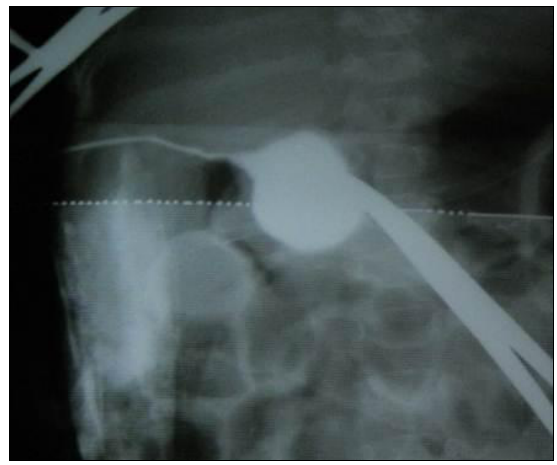
Figure 2: Peroperative cholangiogram showing gall bladder draining into CDC with lack of opacification of proximal hepatic ducts and no dye seen entering the